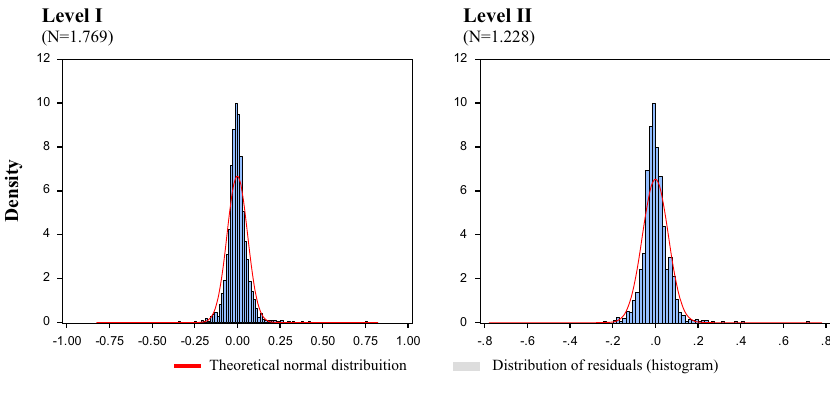
Fig. 2 Normally distributed